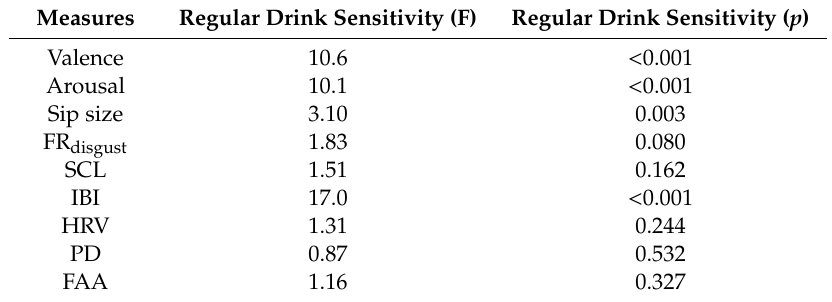
Table 2. F and p -values of each measure with ANOVAs reflecting the e ff ect of the eight regular drinks.